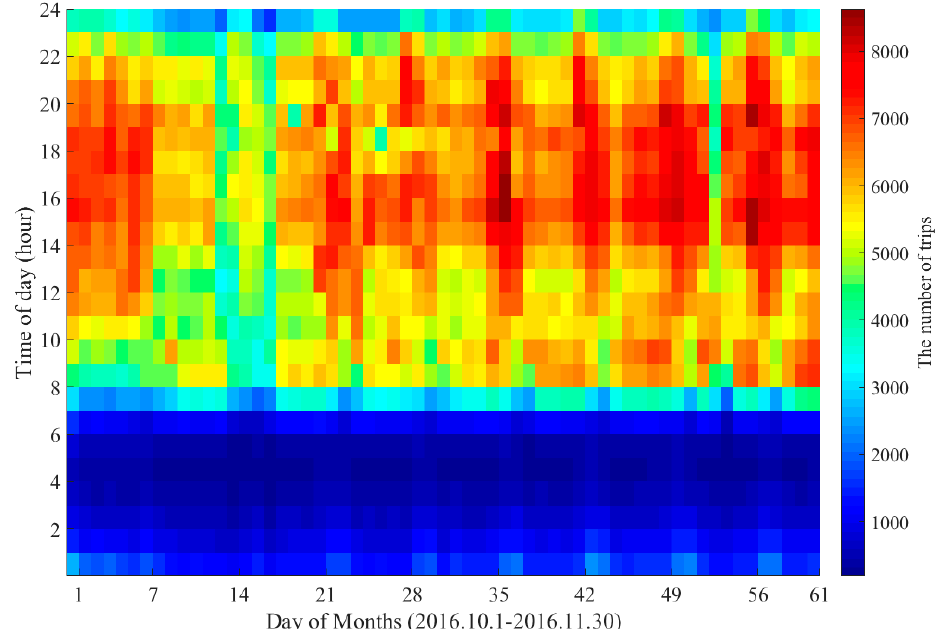
Figure 1. Distribution of hourly trip quantity.